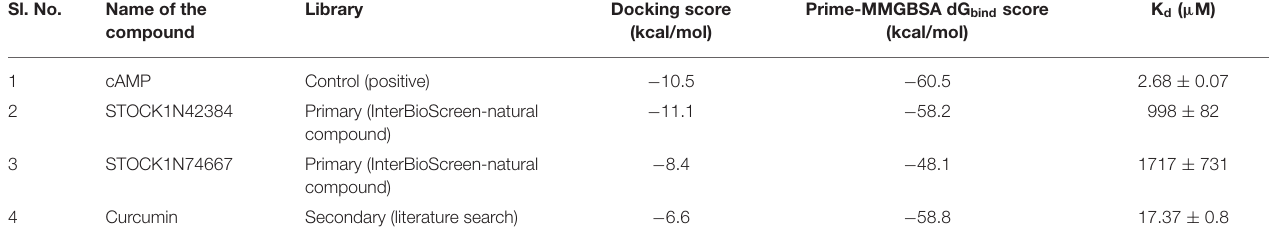
TABLE 2 | Binding affinity (K d ) of experimentally tested compounds as determined by MST assays. Sl. No.